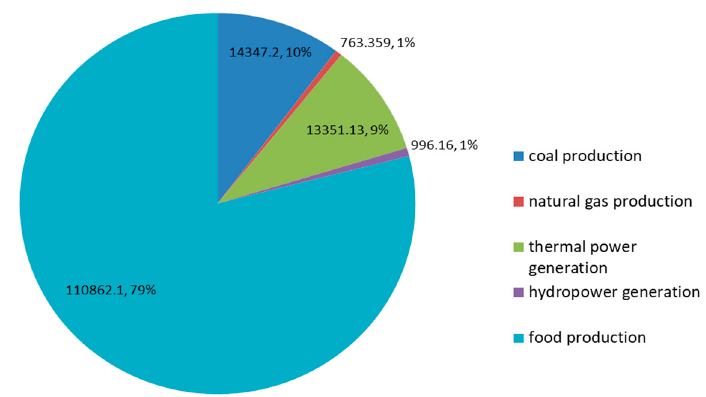
Figure 4. The pie chart of water resource utilization.